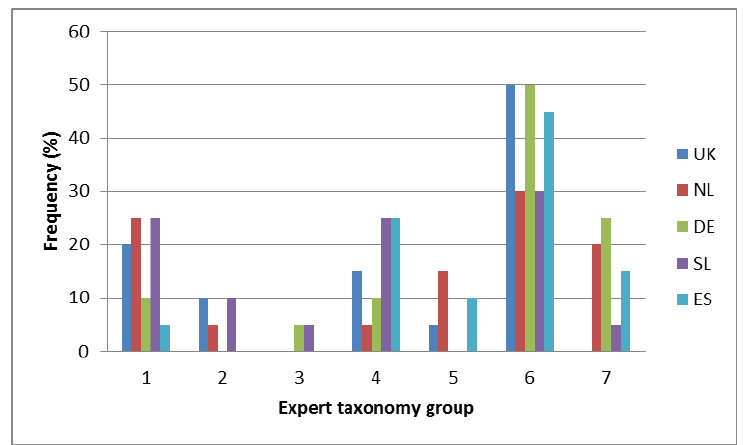
Figure A4. Frequency of structured sort placement of nutrition claims per country—‘No added sugar’ (Card 22).